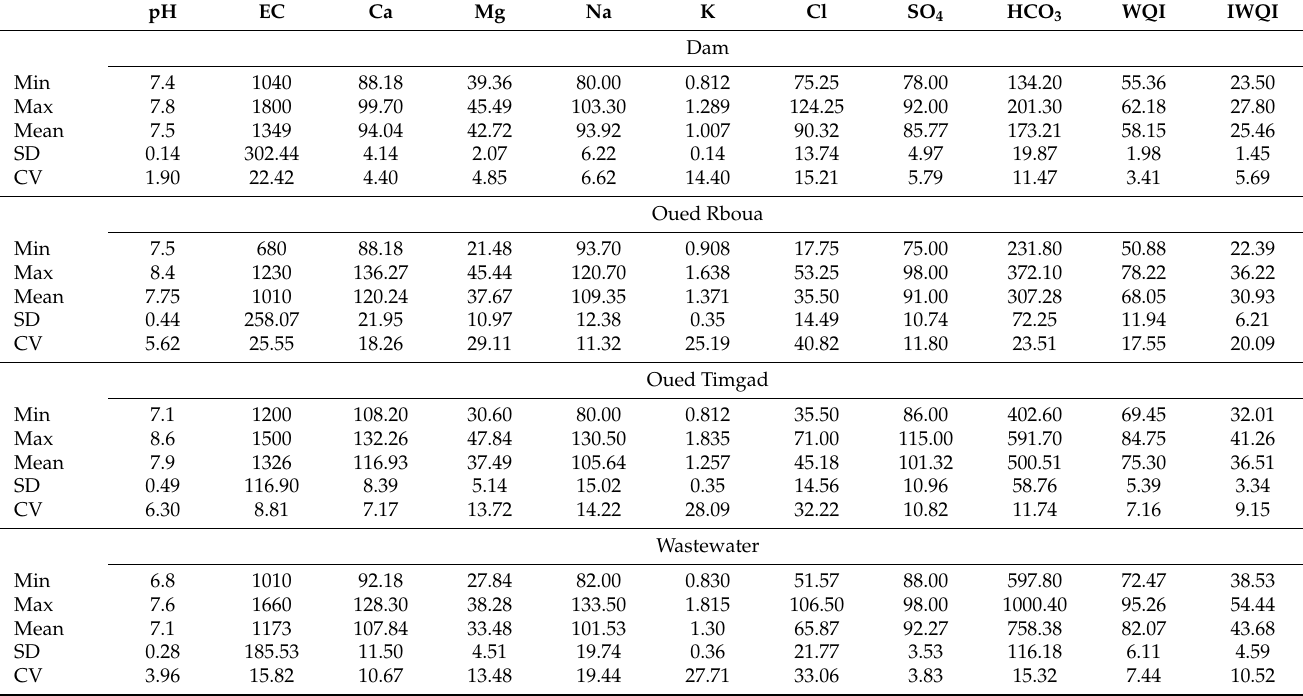
Table 5. Summary statistics of hydrochemical parameters of the surface water samples.